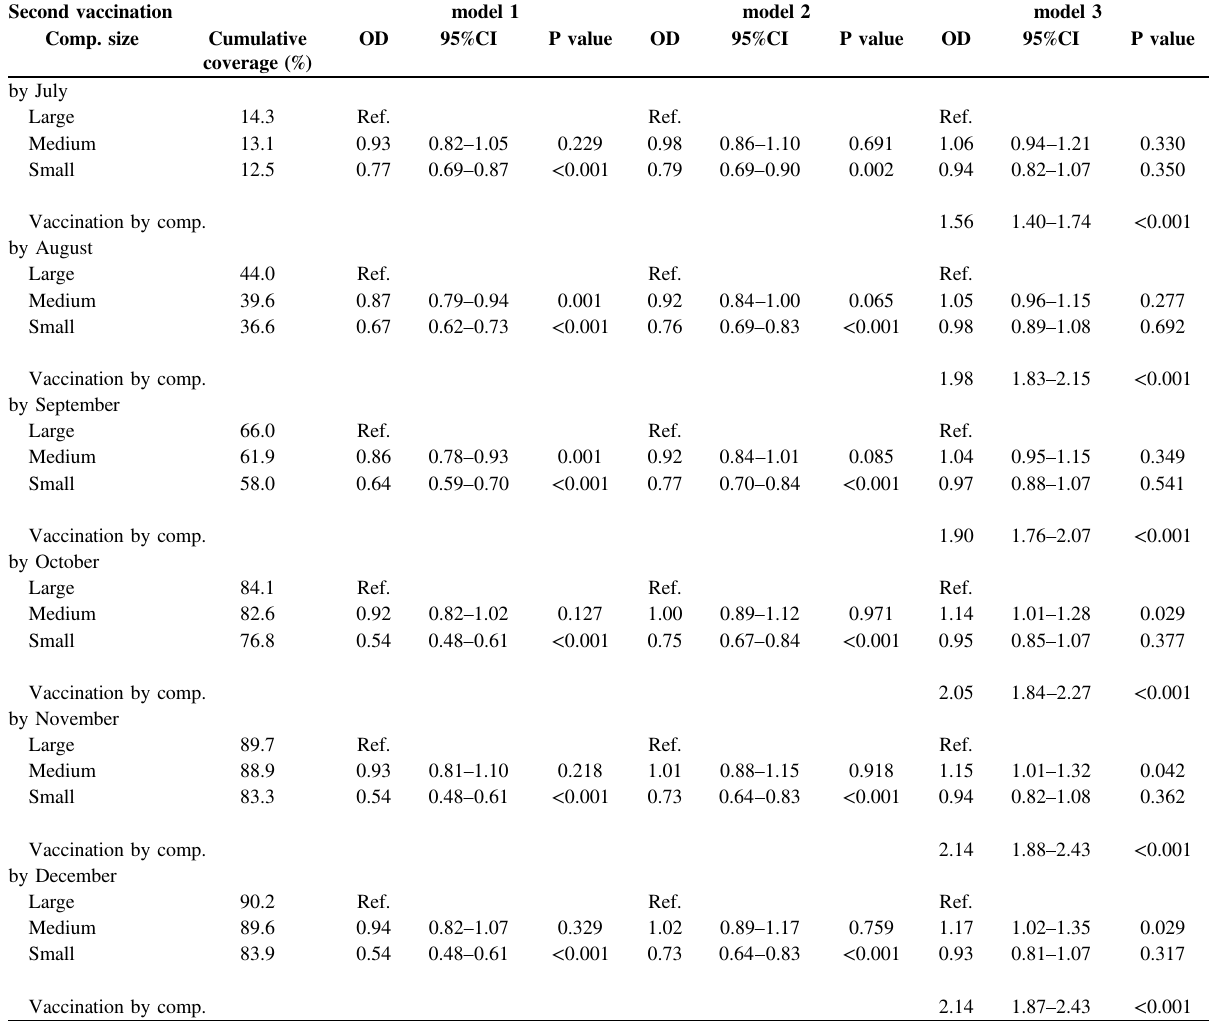
Table 2 Association between company size and completion of the second COVID-19 vaccine dose Second vaccination model 1 Comp. size